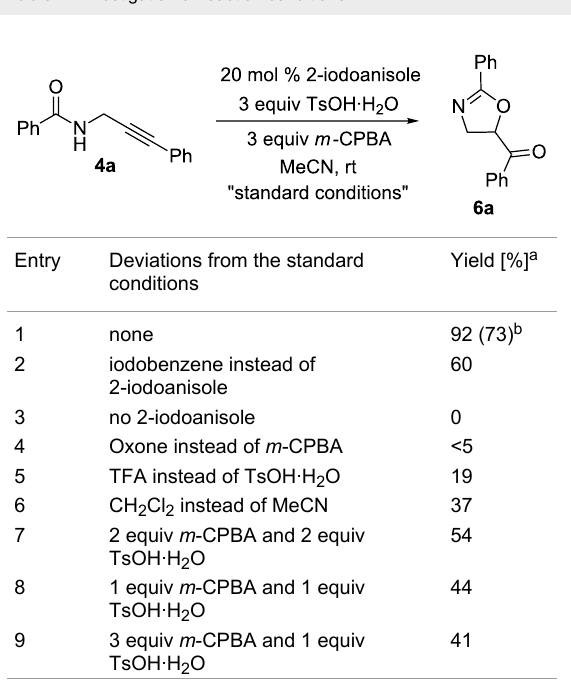
Table 1: Investigation of reaction